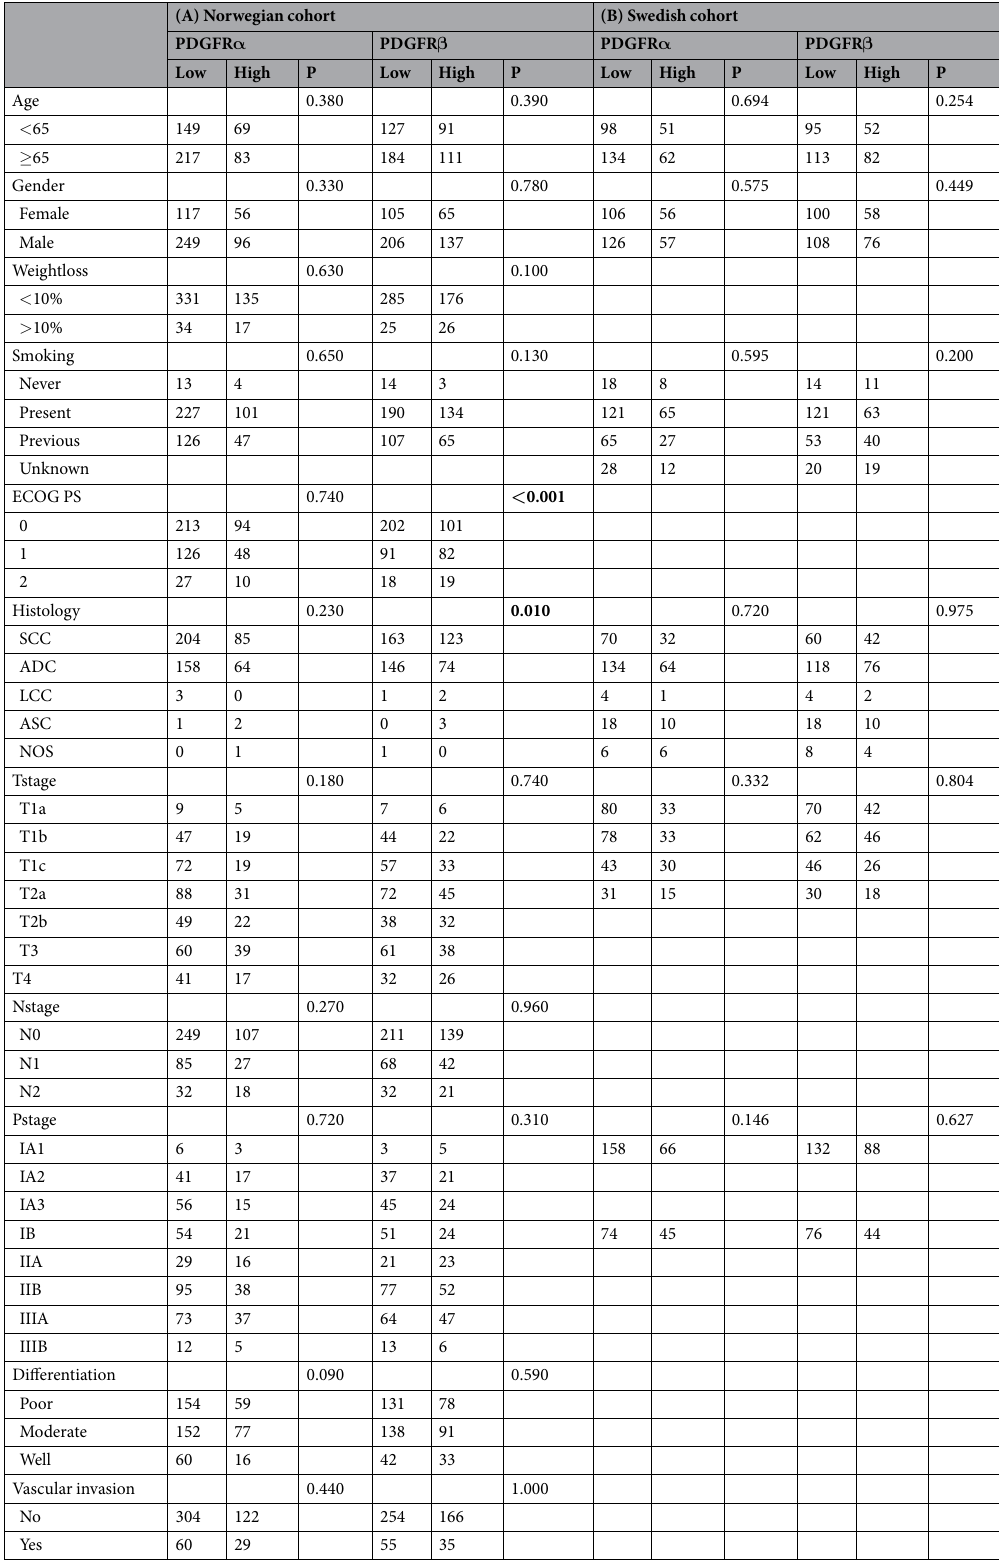
Table 2. Correlations between clinicopathological variables and PDGFR α and- β in the (A) Norwegian cohort and (B) Swedish cohort (chi-square and Fisher’s exact tests) Abbreviations: PDGFR. Platelet-derived growth factor receptor; ECOG PS, Eastern Cooperative Oncology Group performance status; ADC, adenocarcinoma; SCC, squamous cell carcinoma; LCC, large-cell carcinoma; ASC, adenosquamous carcinoma; NOS, not otherwise specified; Tstage, tumor stage; Nstage, nodal stage; Pstage, pathological